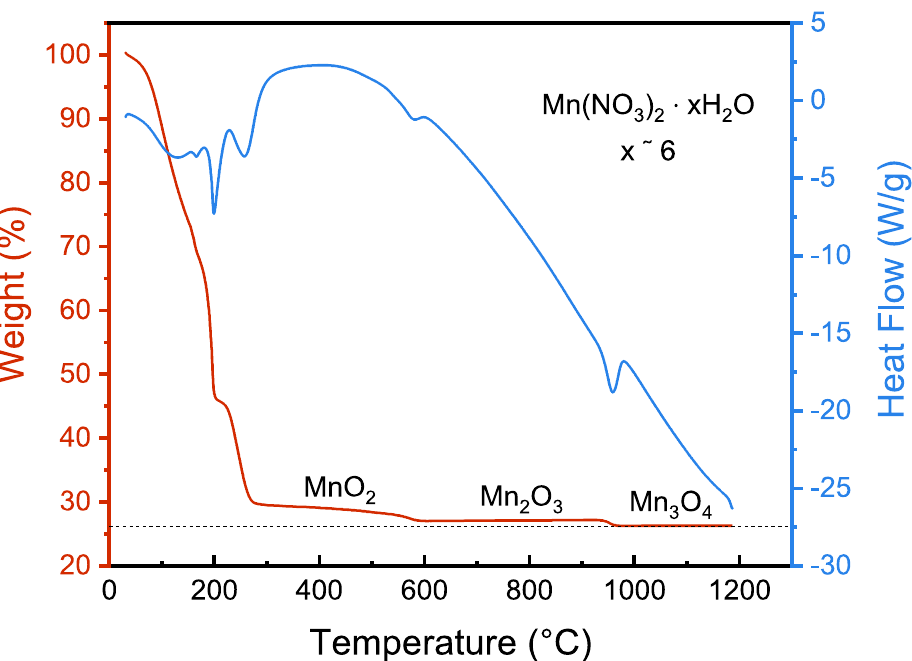
Figure 2. Simultaneous differential scanning calorimetry and thermal gravimetic analysis (SDT) of manganese nitrate hydrate performed in air from 25 to 1200 ◦ C. The nitrate decomposes into manganese oxide and the concentration of hydrates in the crystal is approximated. The dashed line represents the theoretical weight percent of Mn 3 O 4 assuming the starting precursor is Mn(NO 3 ) 2 • 6H 2